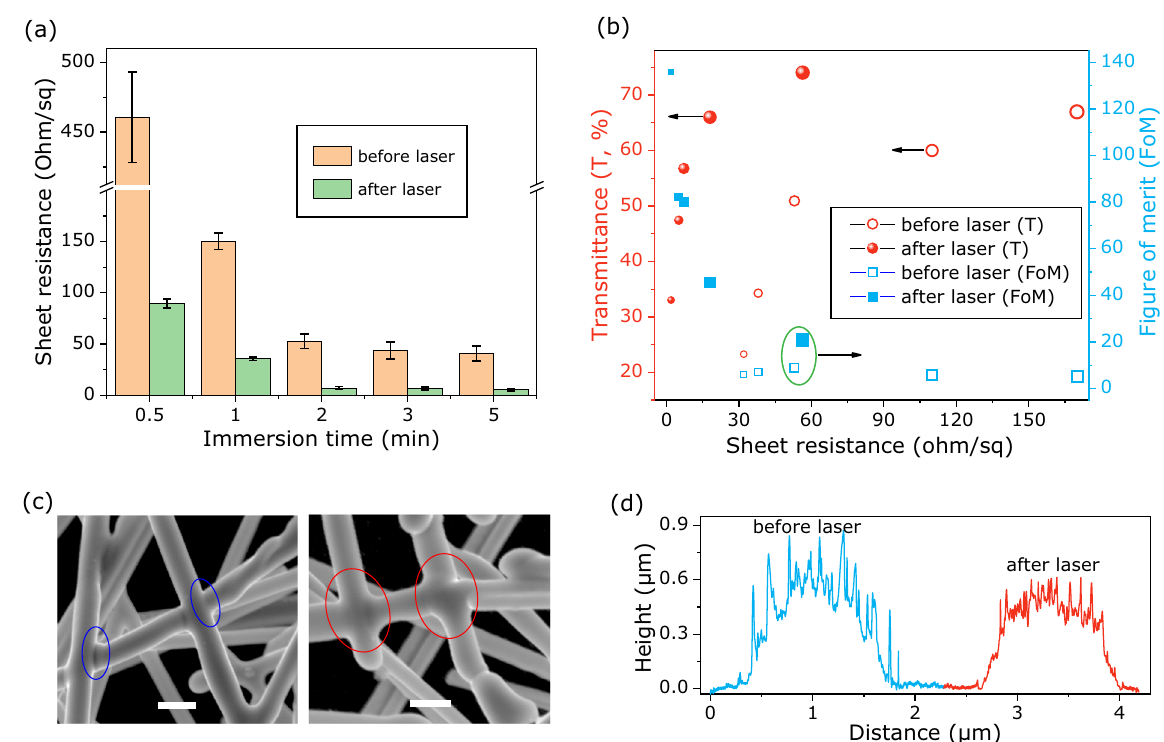
Fig. 3 Properties of the screen-printed and laser-treated Ag NW patterns. a Dependence of the sheet resistance of the fabricated screen- printed Ag NWs after immersion in acetone for various time periods and laser treatment. b The measured transmittance at the wavelength of 550 nm (spheres) and the FoM (squares) as a function of the sheet resistance of the screen-printed Ag NW fi lms. The faster printing speed, higher force, smaller gap, and larger number of printing cycles indicate the smaller of the plotted markers. Markers with the same size represent the same sample before (empty) and after (solid) laser treatment. c SEM image of Ag NW junctions after laser treatment. The junctions are welded (blue circles) and even tightly connected (red circles) after laser treatment. The scale bars are 100 nm. d Pro fi le of the screen-printed Ag NW fi lm before (black line) and after (red line) laser treatment, indicating a slight reduction in the thickness of the Ag NW layer after laser